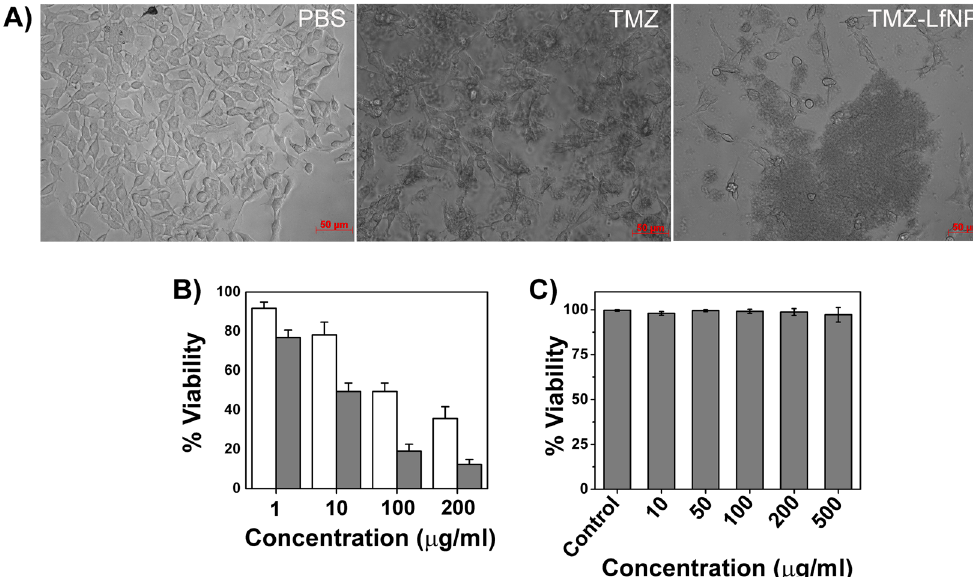
Figure 3. ( A ) Representative microscopic images of untreated cells (left), cells treated with 100 µ g ml − 1 of TMZ (middle) and TMZ-LfNPs-treated cells (equivalent dose) (right). (B) GL261 cells treated with different concentrations of TMZ (white bars) and equivalent doses of the TMZ-LfNPs (grey). (C) Assessment of biocompatibility of LfNPs. Each data points were repeated in triplicates (n = 3) and presented as Mean ± Standard Deviation